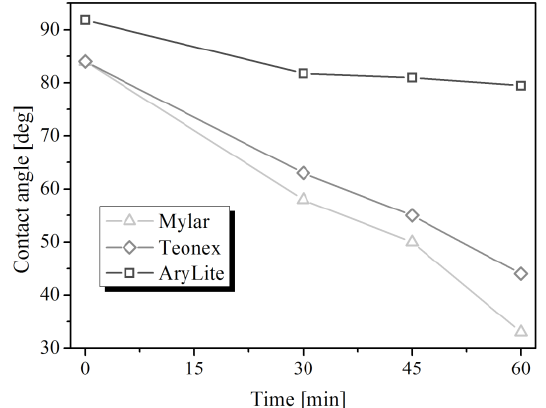
Figure 6. Water Contact Angle of Mylar TM , Teonex TM , and AryLite TM treated with NaOH solution for different